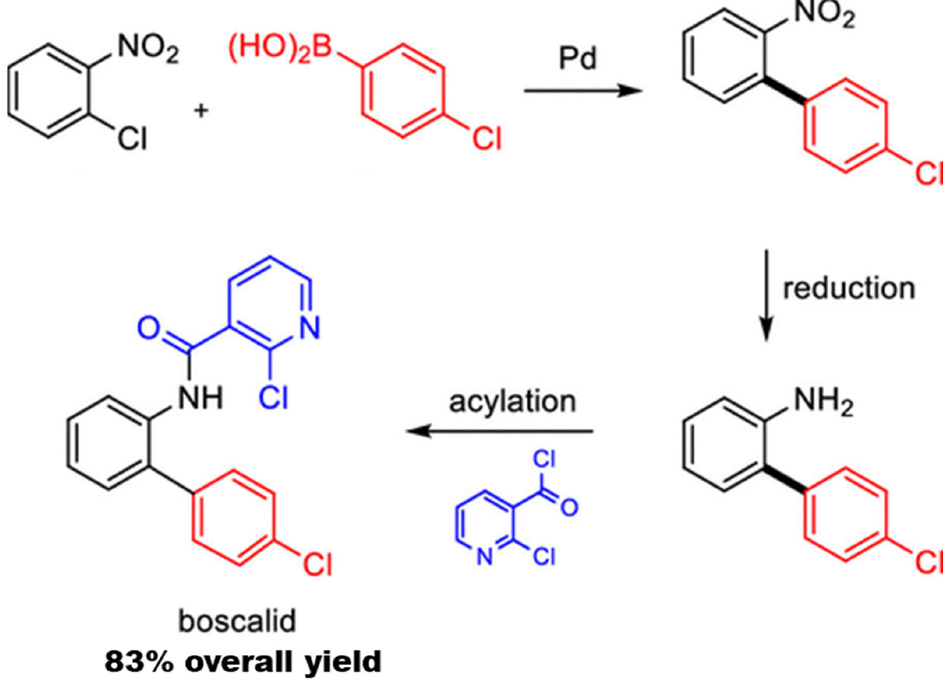
Figure 11. One-pot, three-step synthesis of boscalid (fungicide) involving Pd-catalyzed Suzuki- Miyaura cross coupling, followed (without isolation of the intermediates) by nitro-group reduction of the nitrobiaryl intermediate and amide formation using TPGS-750-M micelles. The product was isolated by extraction with ethyl acetate and further purified using flash chromatography. An 83% overall yield was achieved. Gram-scale (1.42 g) production was demonstrated. Adapted from [130] with permission.